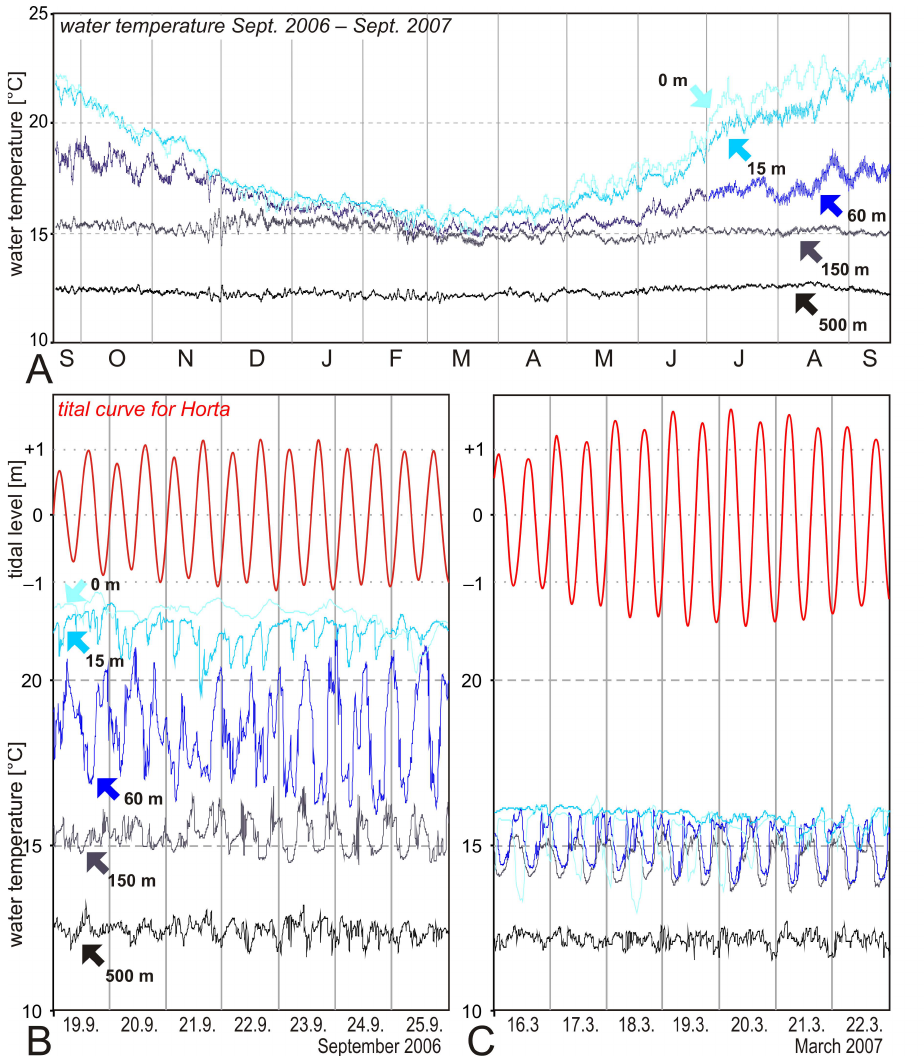
Fig. 3. (A) Temperature logs (24h running mean) at the various experimental sites showing a sinusoidal seasonality with maximum mean temperatures in September and minimum values in March, decreasing in amplitude and absolute value with depth. (B–C) Hi-res temperature record of one week during spring/neap-tide in September 2006 and March 2007, plotted together with the tidal curve at Horta. Please note that the direct influence of the tidal rhythm upon short-term fluctuations is most pronounced during autumn in 60m water depth close to the thermocline that is shifting driven by the tidal currents. During low-temperatures in the springtime temperature differences and stratification